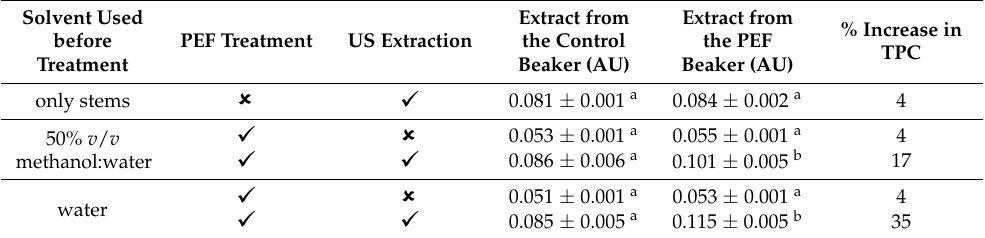
Table 1. Absorption of samples, resulting from various treatments, using the Folin–Ciocalteu method. Statistically significant differences ( p < 0.05) are denoted with superscript letters; AU: Absorbance units.